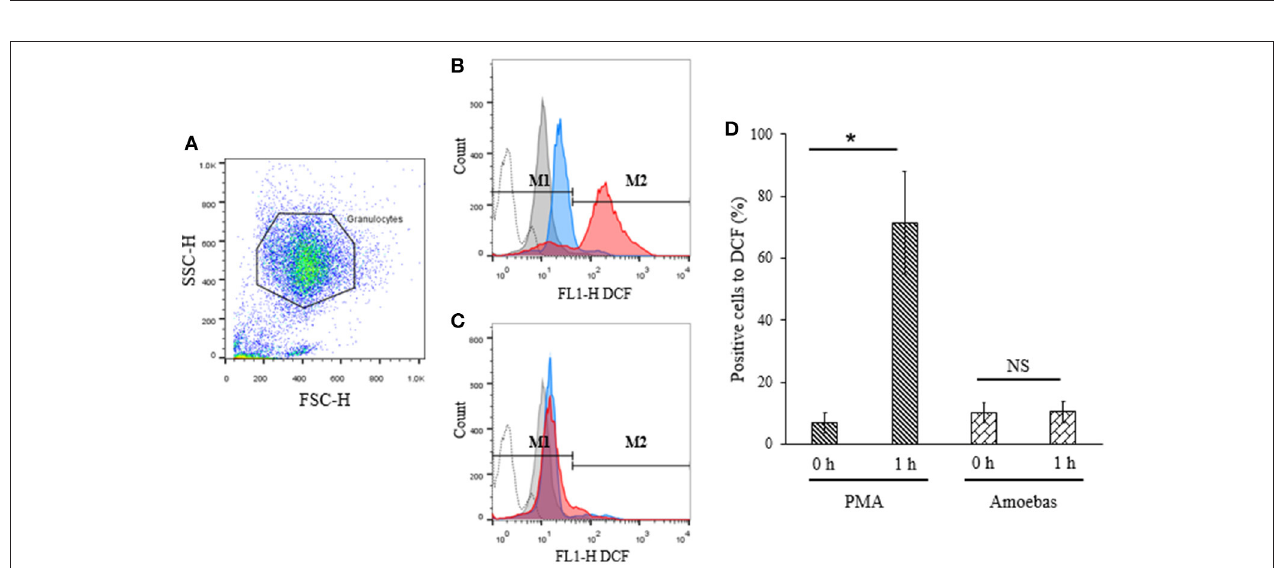
FIGURE 8 | ROS were not detected during neutrophil–amoeba interaction. Neutrophils (1 × 10 6 ) were pre-incubated with 10 µ M H 2 DCFDA for 30min and stimulated with 5 × 10 4 trophozoites or 20nM PMA for 1h. DCF fluorescence was measured using a FACScalibur cytometer. (A) Neutrophils population selected for analysis. (B) Histogram of neutrophils stimulated with PMA. (C) Histogram of neutrophils co-cultured with trophozoites. M1 negative region (cells with low fluorescence); M2 positive region (cells with high fluorescence). Histograms: dotted, autofluorescence; gray, non-stimulated; blue, stimulated 0h; red, stimulated 1h. (D) Percentage of positive cells to DCF respect to the control. Values are means ± SD of three independent experiments. * p < 0.001. NS, statistically